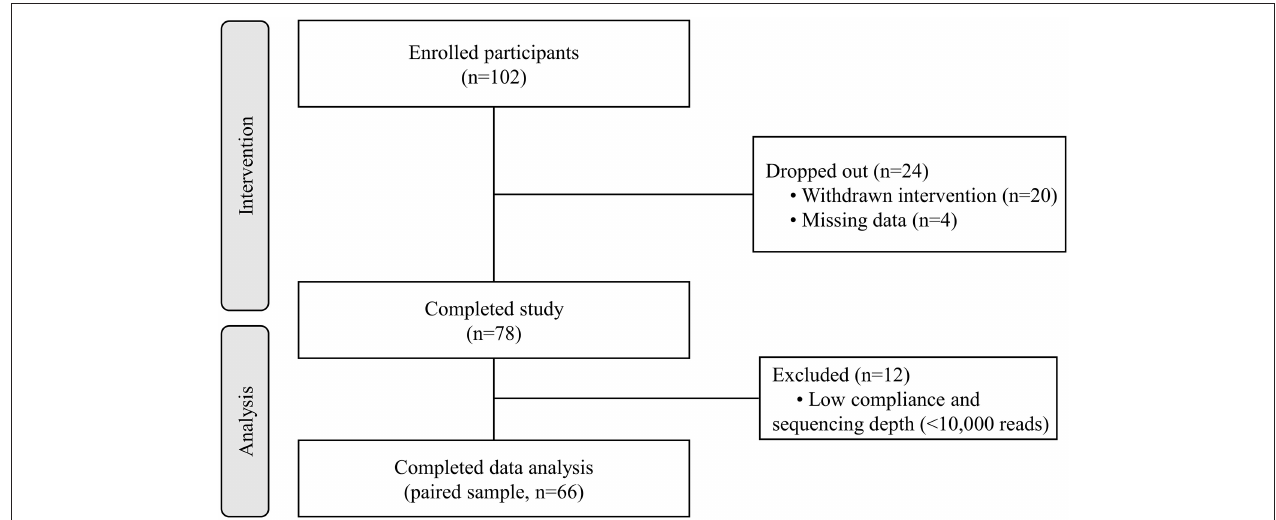
FIGURE 1 | Flow diagram of the